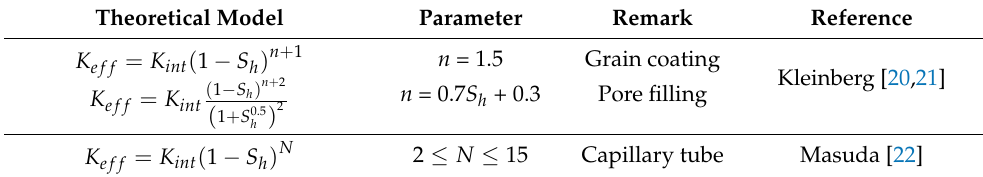
Table 1. Effective permeability